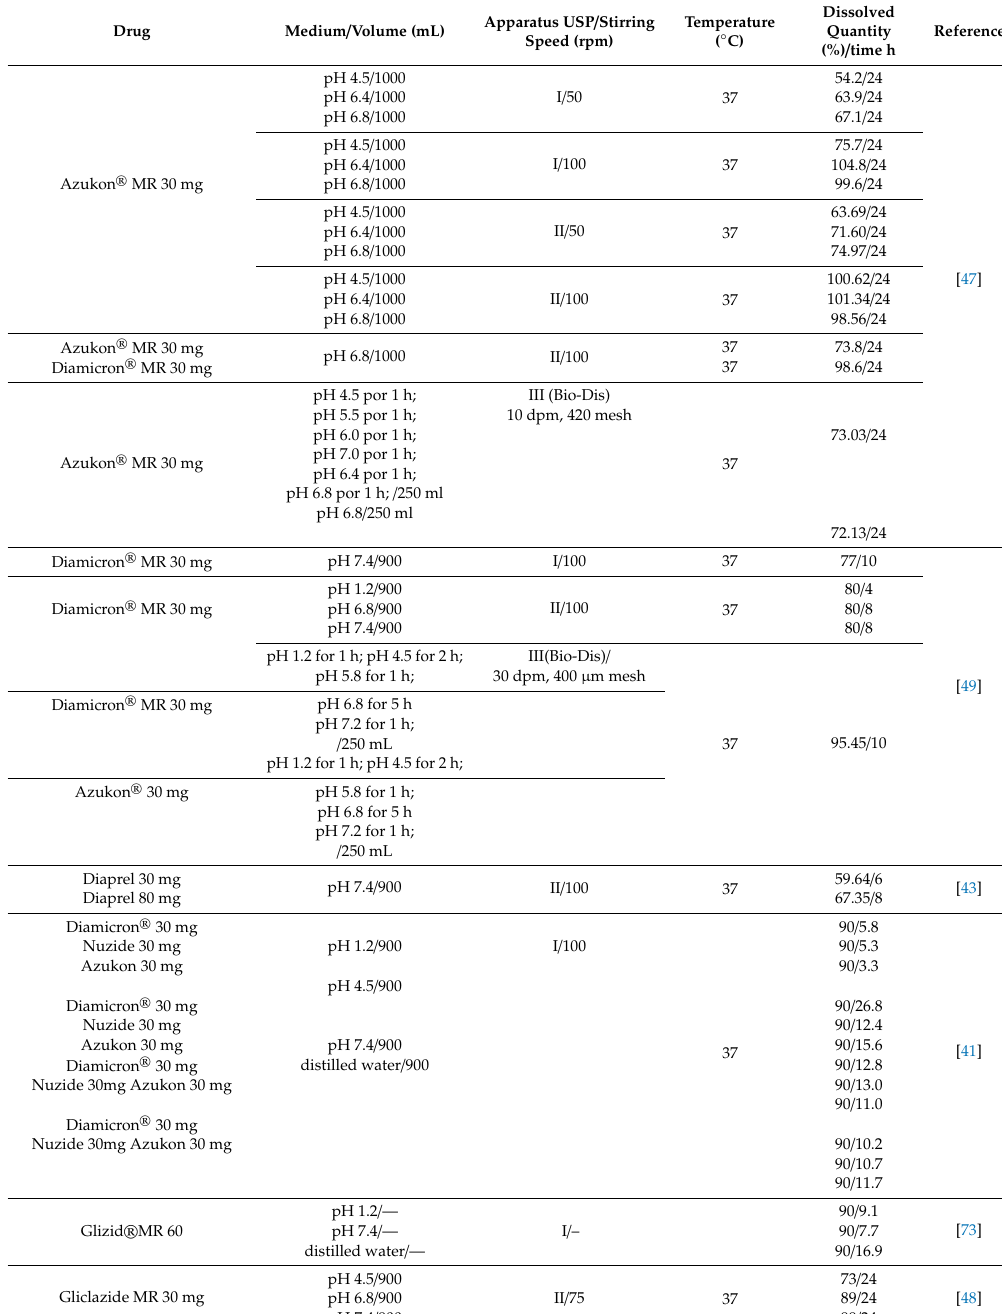
Table 5. Experimental conditions for dissolution studies and percentage of dissolved glicazide from extended-release solid oral dosage